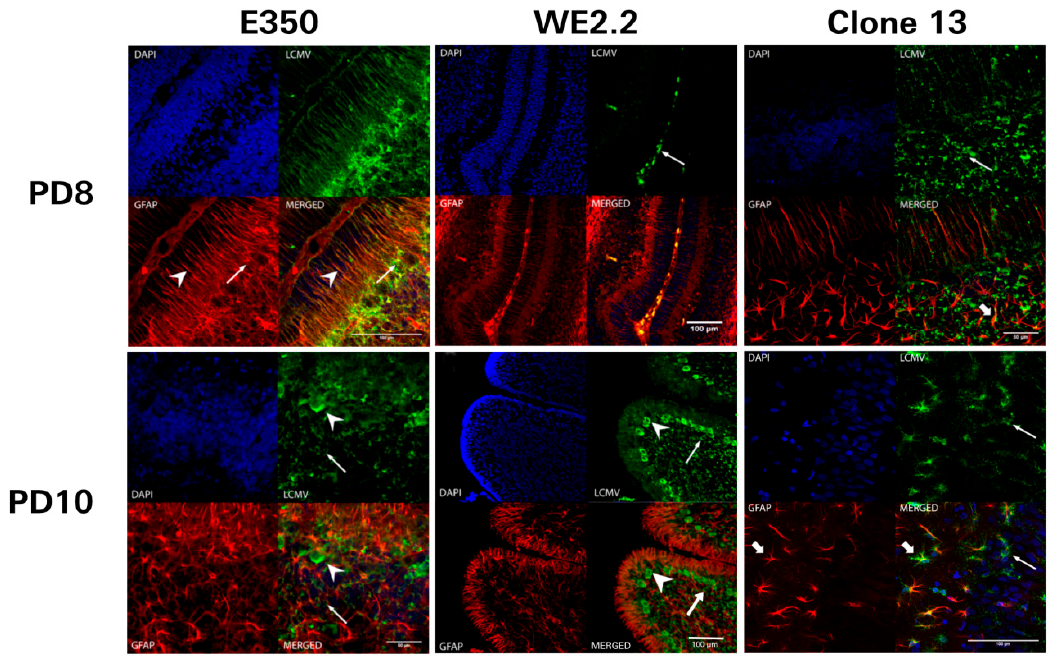
Figure 7. The different strains of LCMV had different initial cellular targets of infection and sequential migration. Pictured here are 40-micron-thick immunohistochemically stained sections (GFAP: red, LCMV: green, DAPI/nucleated cells: blue, bottom right: merged image) from PD8 (upper row) and PD10 (lower row) cerebellar tissue from rats infected with different strains of LCMV. For the animals inoculated with E350 (left column), Bergman glia (arrowhead) and astrocytes (arrows) are the initial cellular targets of infection on PD8. Thus, no neurons are infected by E350 on PD8, and all infected cells are GFAP-positive. However, by PD 10, E350 has spread to infect many granule neurons (arrow) and Purkinje neurons (arrowhead). This pattern of infection is in stark contrast to that observed with WE2.2 (middle column), where initial infection on PD8 is limited to the meninges (arrow) and no parenchymal cells are infected. By PD 10, WE2.2 has moved into neurons and exclusively infects granule neurons (arrow) and Purkinje neurons (arrowhead). In Clone 13, initial infection on PD8 was limited to granule cells (arrows). By PD10, the infection had spread to Purkinje cells (thin arrows) and a few astrocytes (thick arrow).